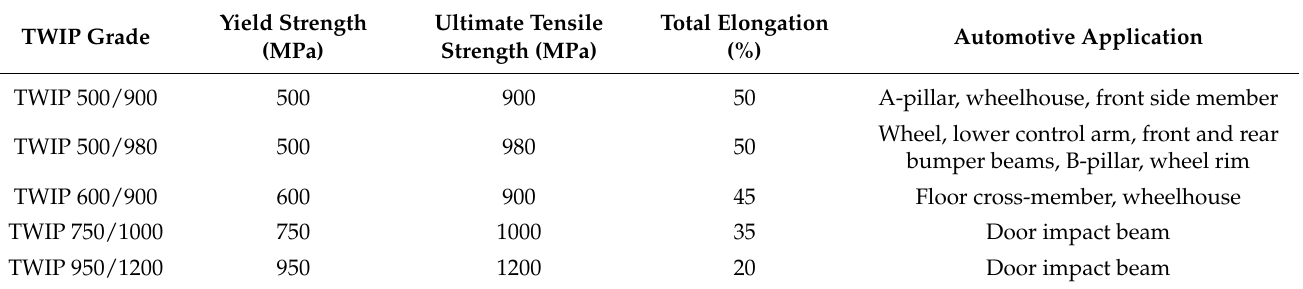
Table 1. Current production grades of TWIP steels for automotive applications